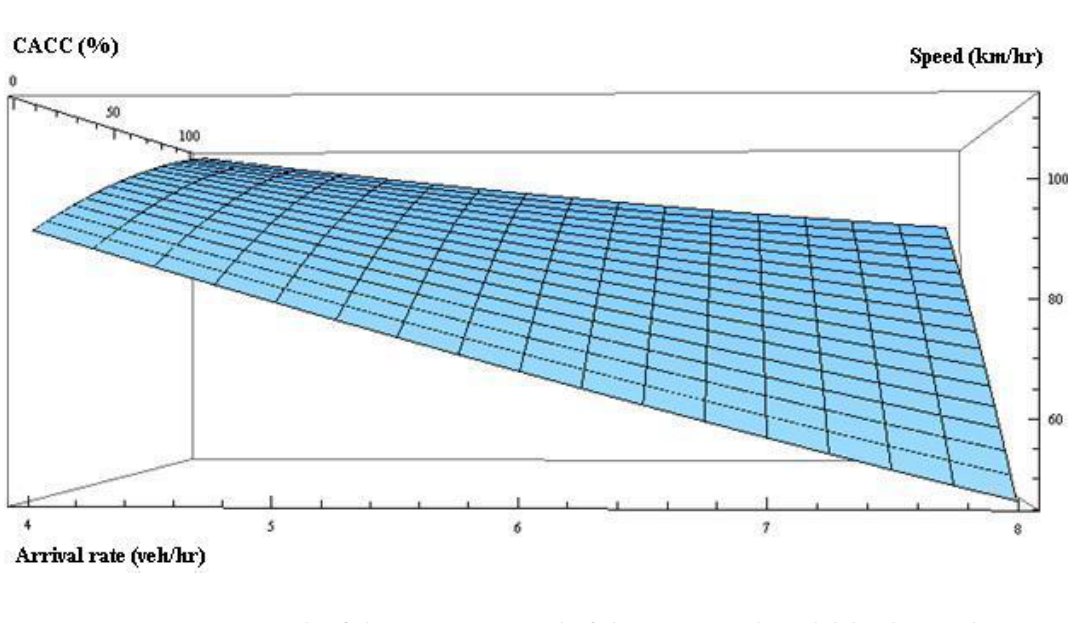
Figure 8a. 3D graph of the average speed of the generated model (with ramp)